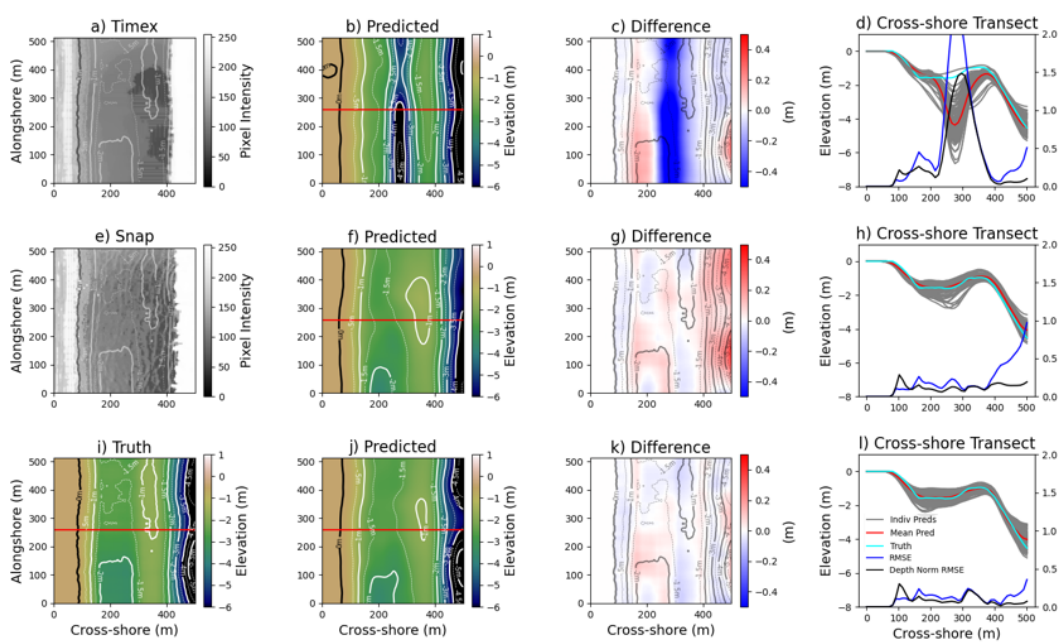
Figure 5. Input features and predictions from three different model runs. The first row shows the timex-only model, with ( a ) showing the timex input image, ( b ) showing the ensemble mean prediction, ( c ) showing the spatial bias relative to ground truth, and ( d ) showing an example transect of the ground truth and ensemble prediction, along with the along-shore averaged root mean squared error (RMSE) and depth-normalized RMSE. The second row is in the same pattern, with the only difference being ( e ) shows the snapshot input. The third row, which shows the model trained on both ( a , e ) as inputs, shows the ground truth in panel ( i ), with ( j – l ) being the prediction, difference, and cross-shore transects of said